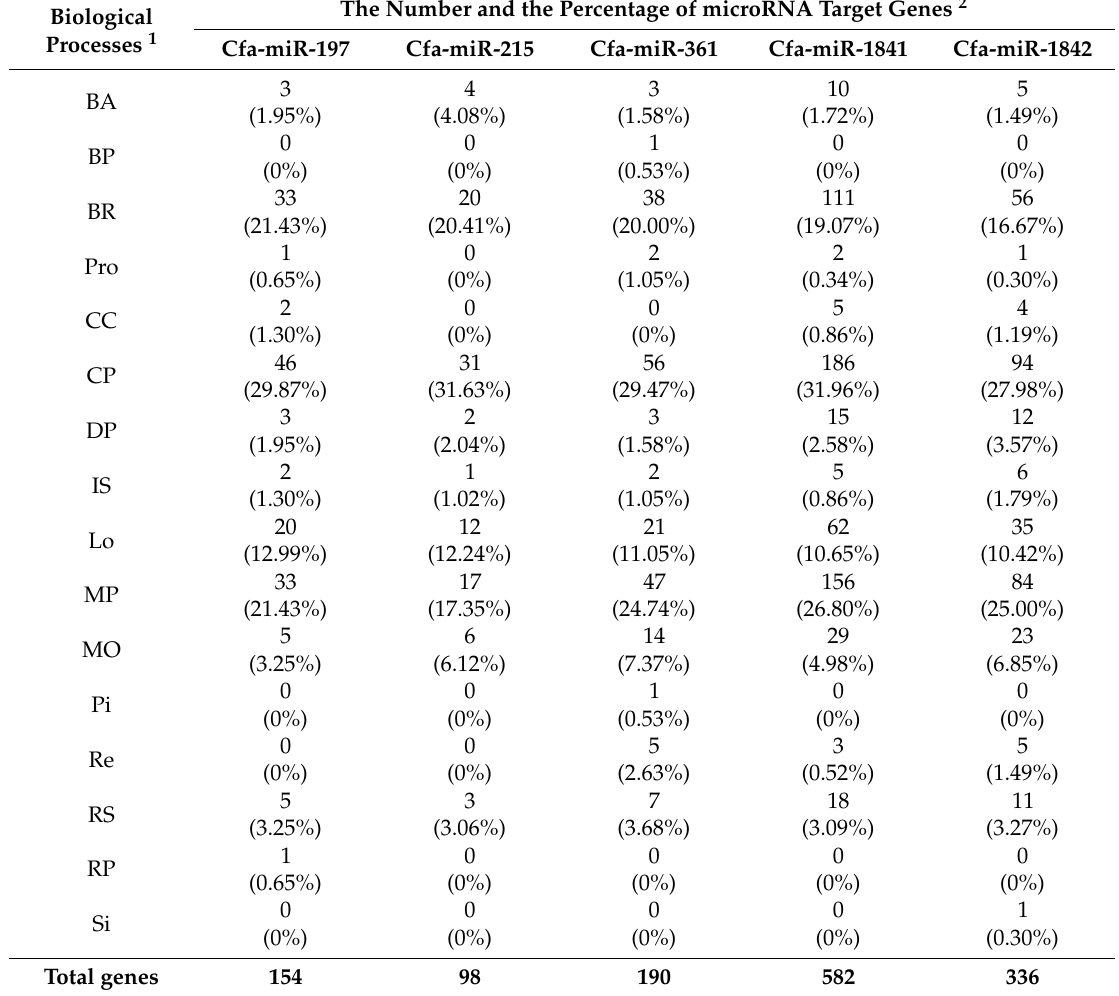
Table 3. The number of predicted microRNA target genes in response to influenza B viruses. Biological Processes